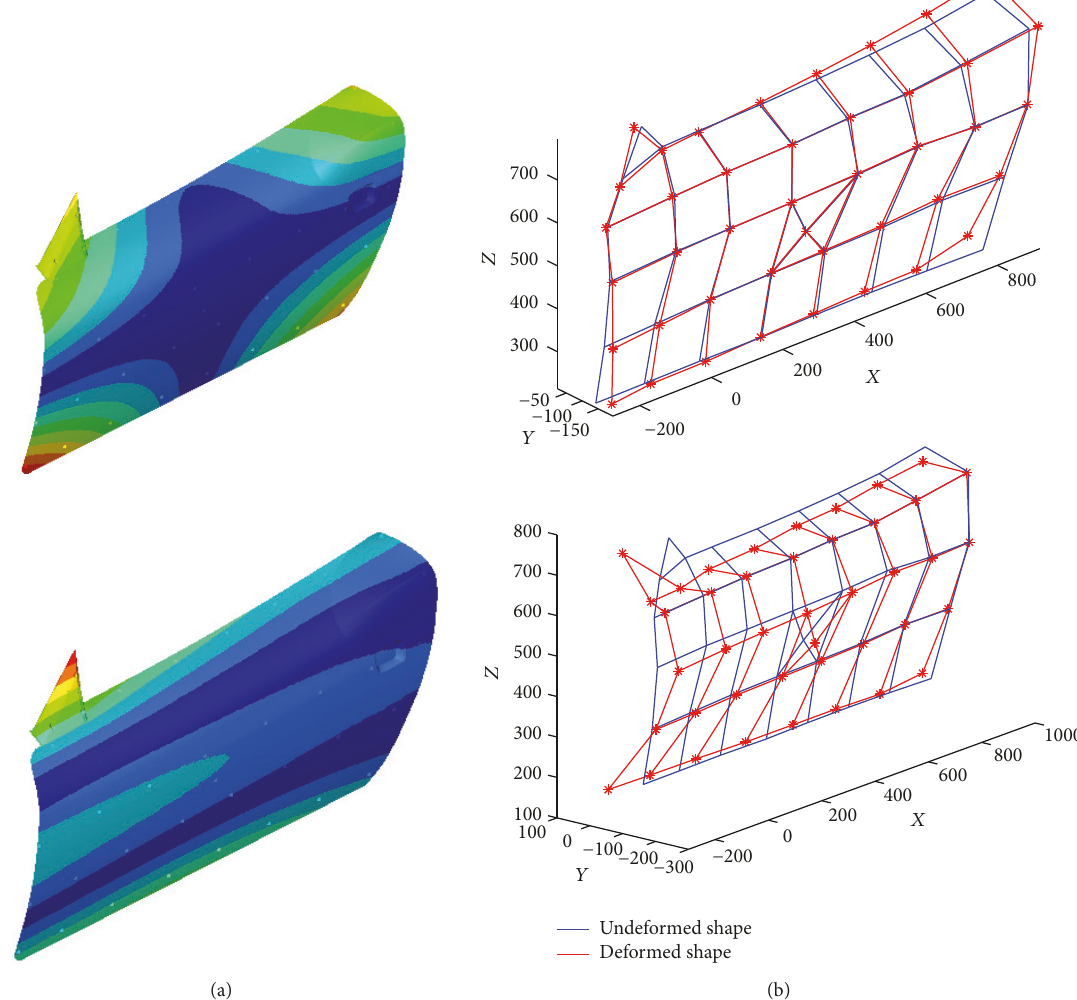
Figure 13: The first two mode shapes after the geometry refinement: (a) FEM; (b) experimental.